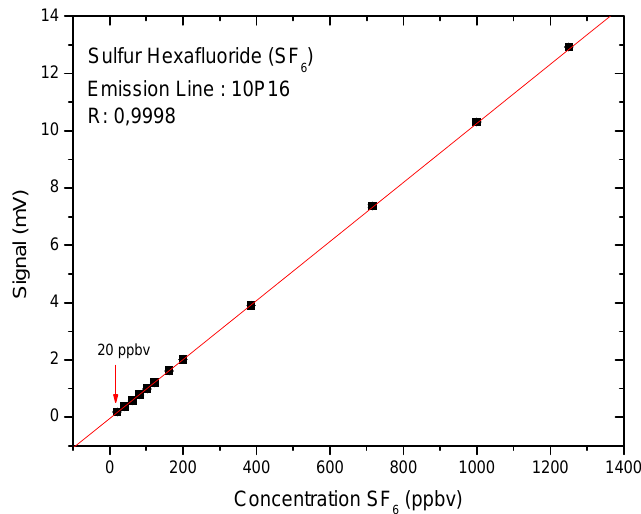
Figure 4. Calibration curve for sulfur